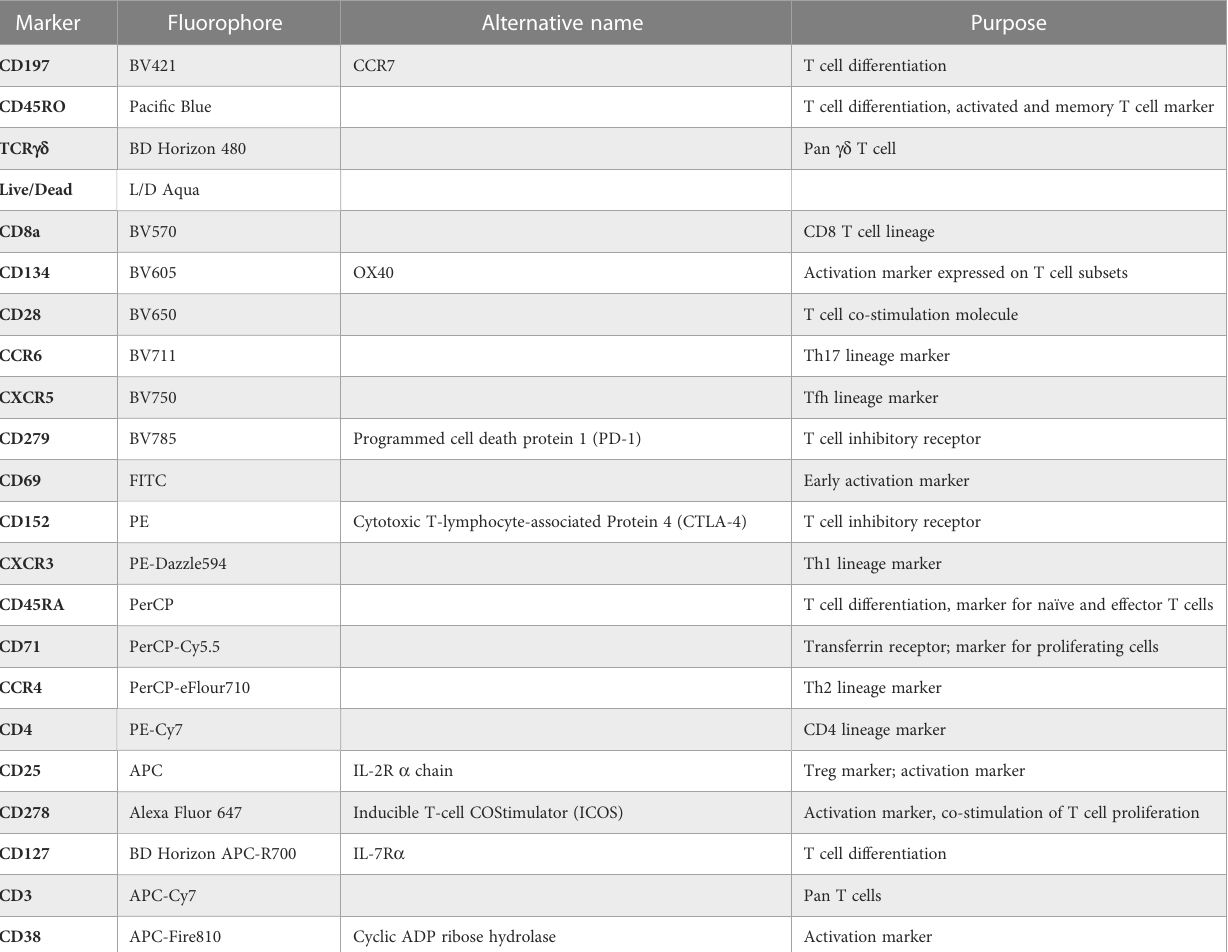
TABLE 2 Descriptive summary of T cell panel.